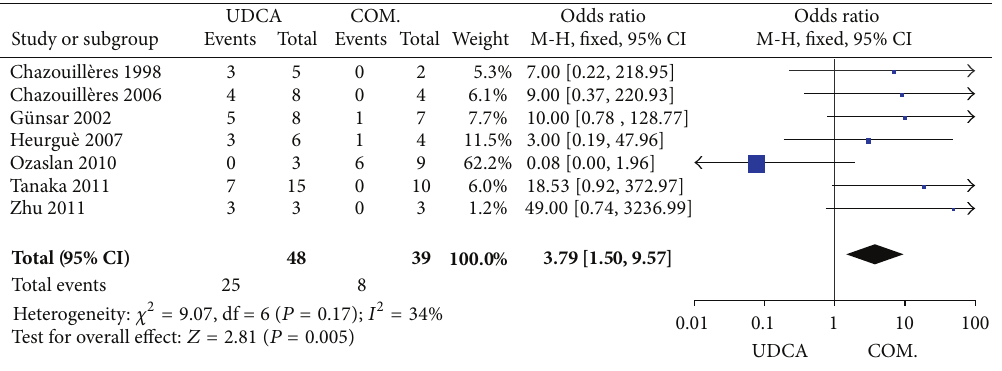
Figure 5: Histological progression in patients treated with monotherapy versus combination therapy for PBC-AIH.